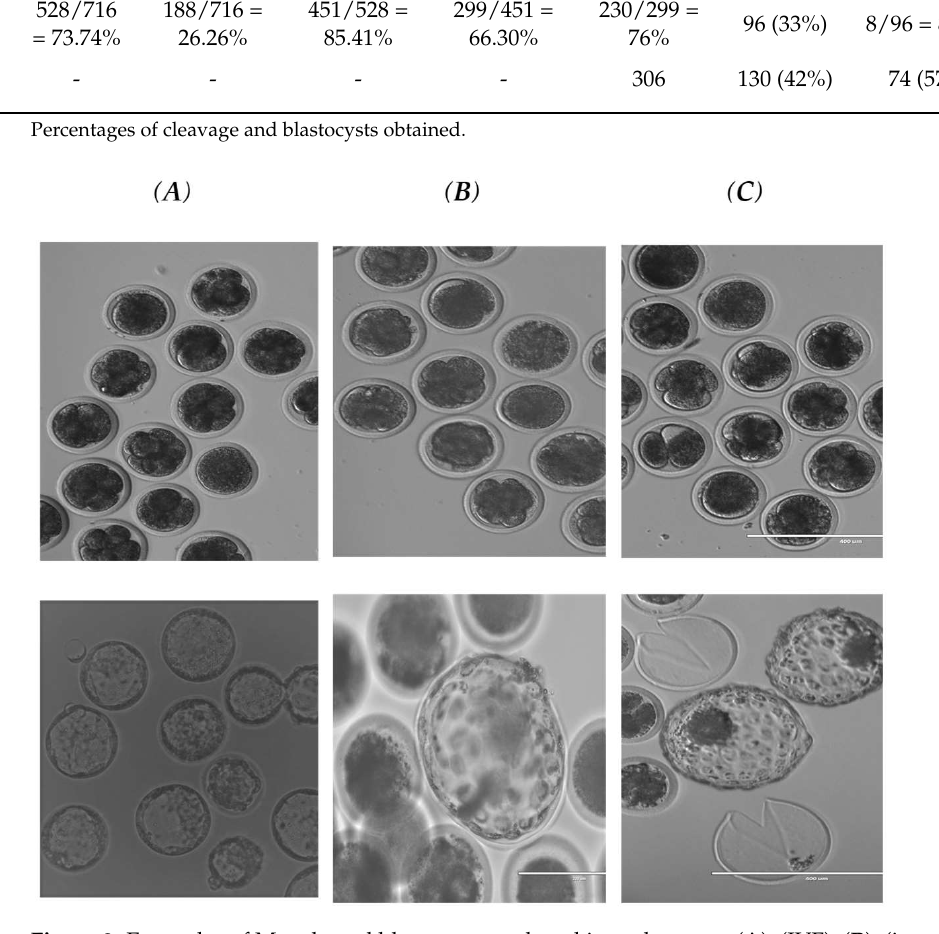
Figure 2. Examples of Morula and blastocyst produced in each group. ( A ): (IVF), ( B ): (interspecific somatic cell nuclear transfer), and ( C ): (SCNT). Table 2. The comparison of the cloned Oryx interspecific somatic cell nuclear transfer, Cow SCNT, and IVF of cow embryo developmental